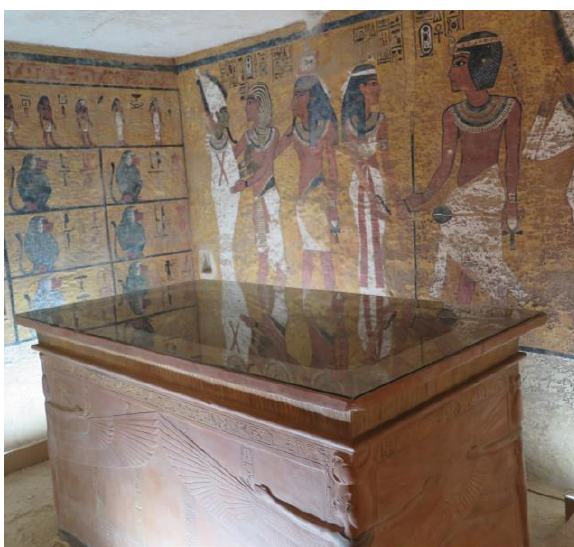
Figure 3. The tomb of Tutankhamen, Valley of the Kings © J. Paul Getty Trust 2015